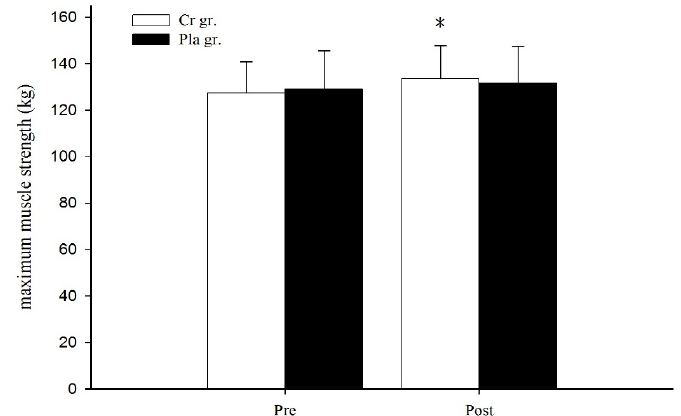
Figure 1. Maximum muscle strength of back squat following creatine or placebo supplementation. Data are the mean ± SD. Asterisk (*) indicates a significant difference ( p < 0.05) from the pre value within the group.